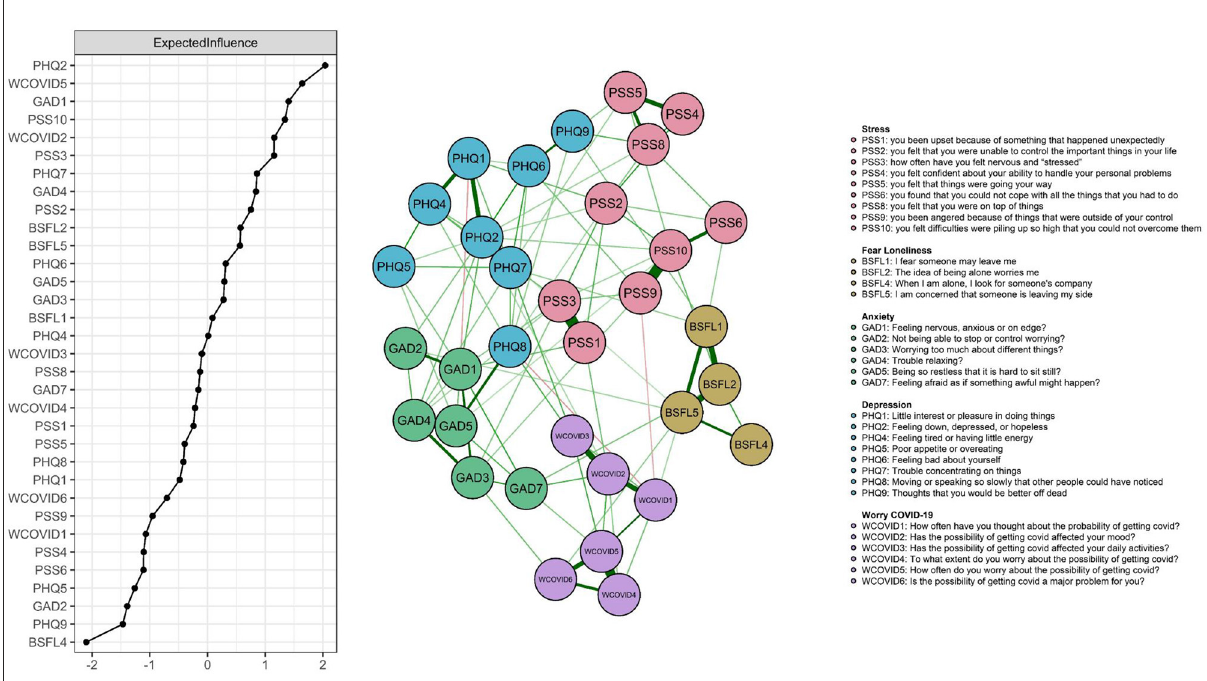
FIGURE1 Network model of anxiety, depression, stress, worry about COVID-19 and fear of loneliness during COVID-19 lockdown in Peru. Expected influence statistics are shown in the left